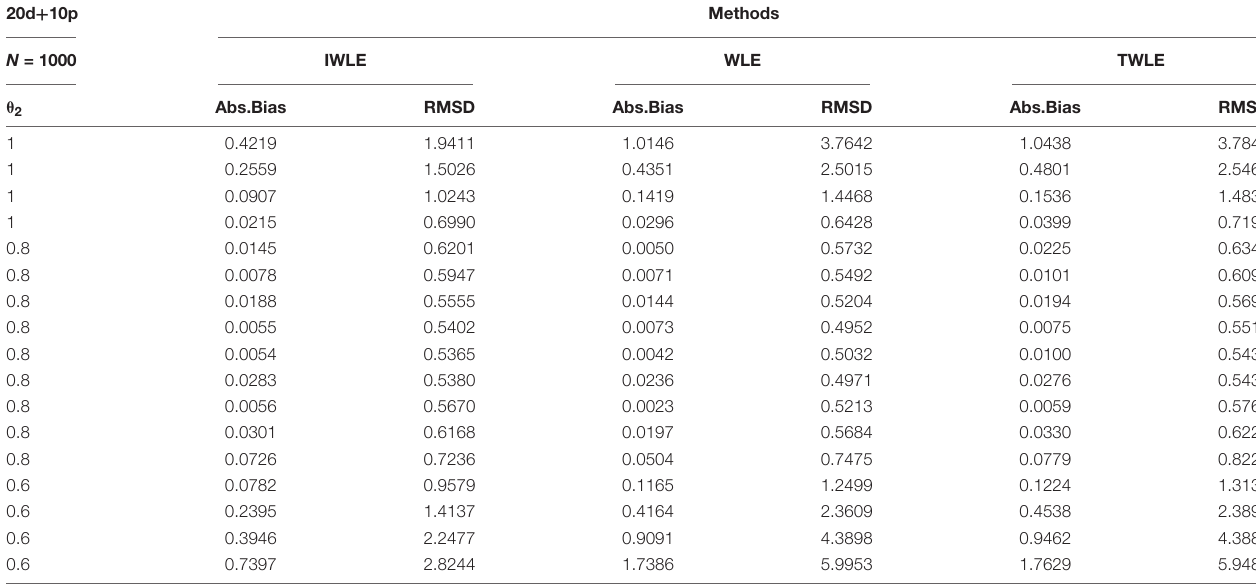
TABLE 3 | Absolute bias and root mean squared difference for WLE, TWLE, and IWLE at 3 different levels of growth on 20d +